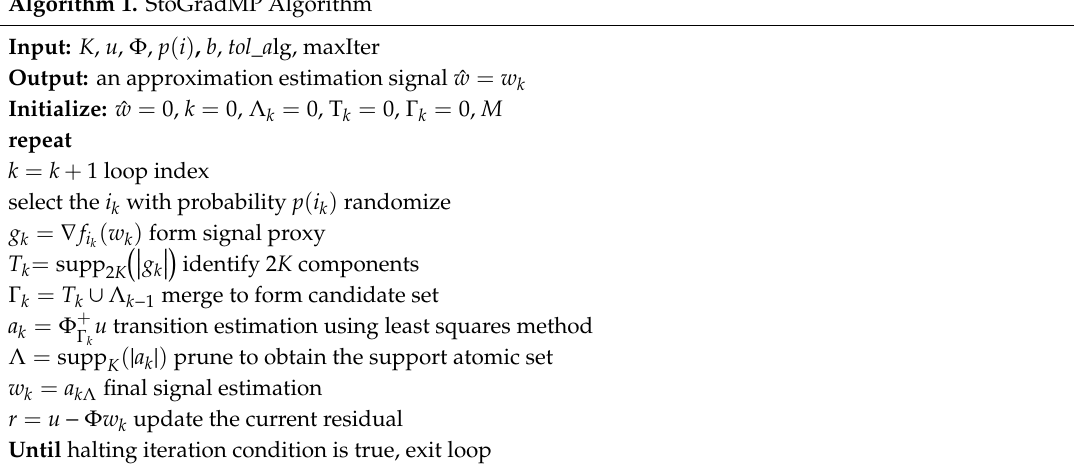
Algorithm 1. StoGradMP